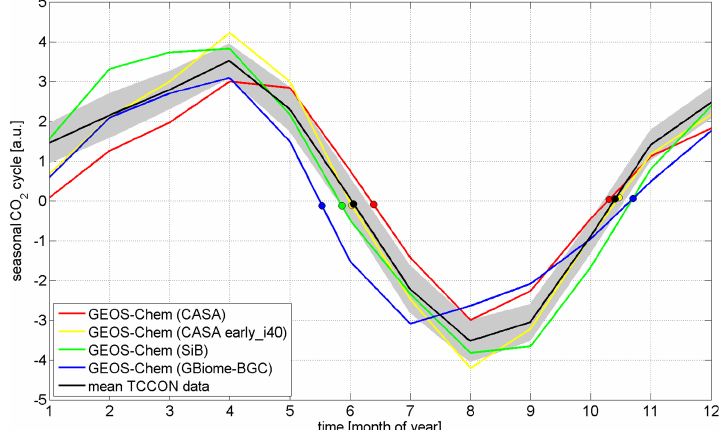
Fig. 3. Averaged seasonal cycles, derived with the averages of the monthly means, shown in Fig. 2. The emerging patterns reveal the characteristics already seen in the NEE inputs. The simulated CO 2 drawdown using SiB or GBiome-BGC starts too early compared to the TCCON measurements and too late using CASA inputs. The seasonal amplitude is slightly overestimated with SiB and underestimated using GBiome-BGC and CASA. The simulated CO 2 release starts too early using CASA and too late using SiB or GBiome-BGC. The zero crossings indicated with dots give an estimate of the delays in the CO 2 drawdown and release (Table 3). The manipulated NEE CASA input leads to a significant improvement of the simulated CO 2 cycle. Even though the seasonal amplitude is overestimated, the timing of the CO 2 drawdown and CO 2 release is estimated accurately (Sect.